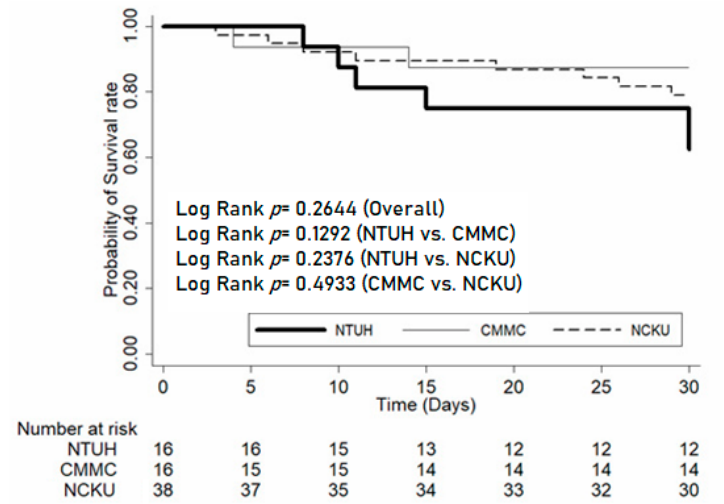
Figure 1. Kaplan–Meier plot; note: survival trend of the 30-day mortality among 3 hospitals using the Kaplan–Meier approach shows no significant difference between each population upon comparison. The digits below the chart were surviving patient numbers of each institute at each point of time. One patient’s outcome was indeterminate in CMMC and was not enrolled in the survival analysis.